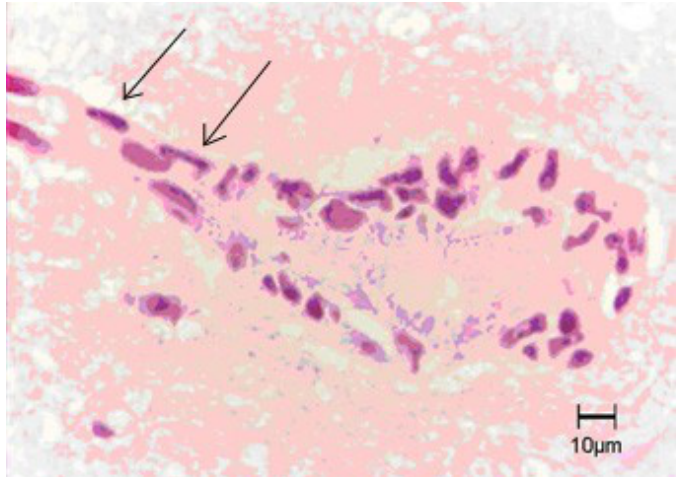
Figure 4: Histological section from the hippocampus of AIRmin mice used as negative controls.